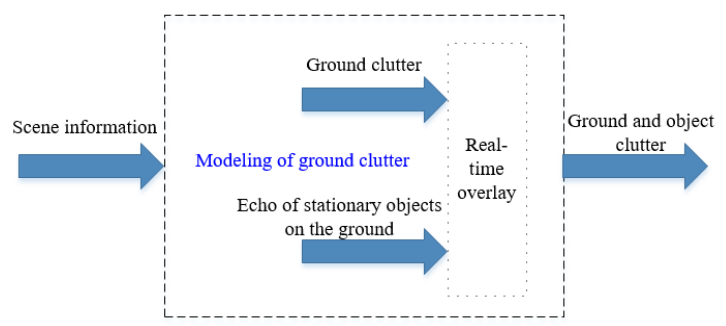
Figure 3. Architecture of ground clutter modeling.